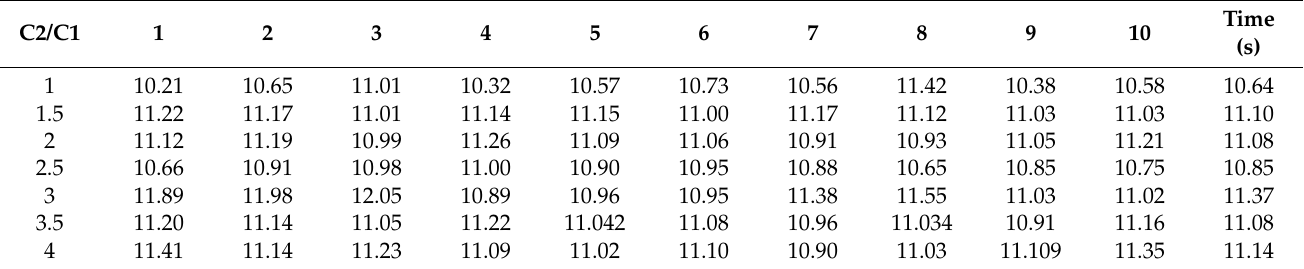
Figure 19. Classification accuracy by different kernel size. As can be seen from the above analysis, different hyperparameters had different ef- fects on the fault diagnosis result. An obvious difference could be found from the analysis of the LR and the kernel size. As for the other parameters, such as the epoch, the batch size, and the kernel number, there was no significant influence on the diagnosis perfor- mance. In particular, only a slight difference was observed with different dropout ratios. 5.2.7. Validation of Diagnostic Model